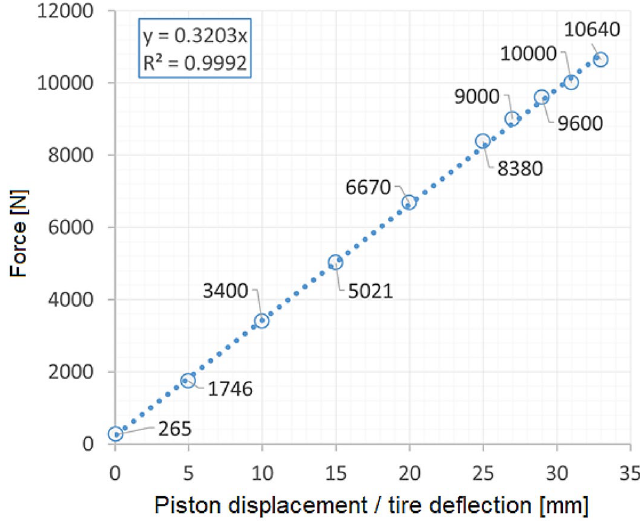
Figure 6. Force versus the tire deflection of the SUV wheel.